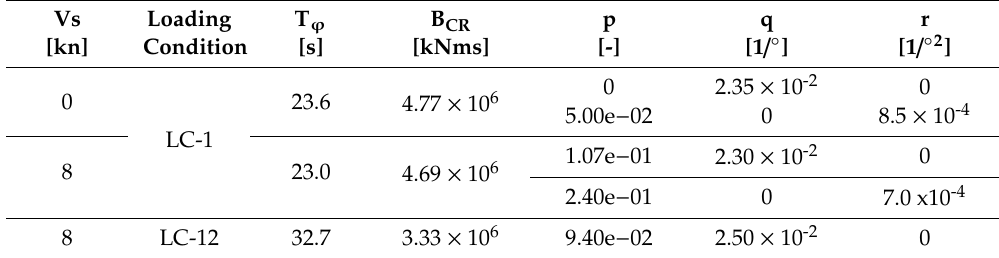
Table 3. Choice of p, q and r coe ffi cients for the